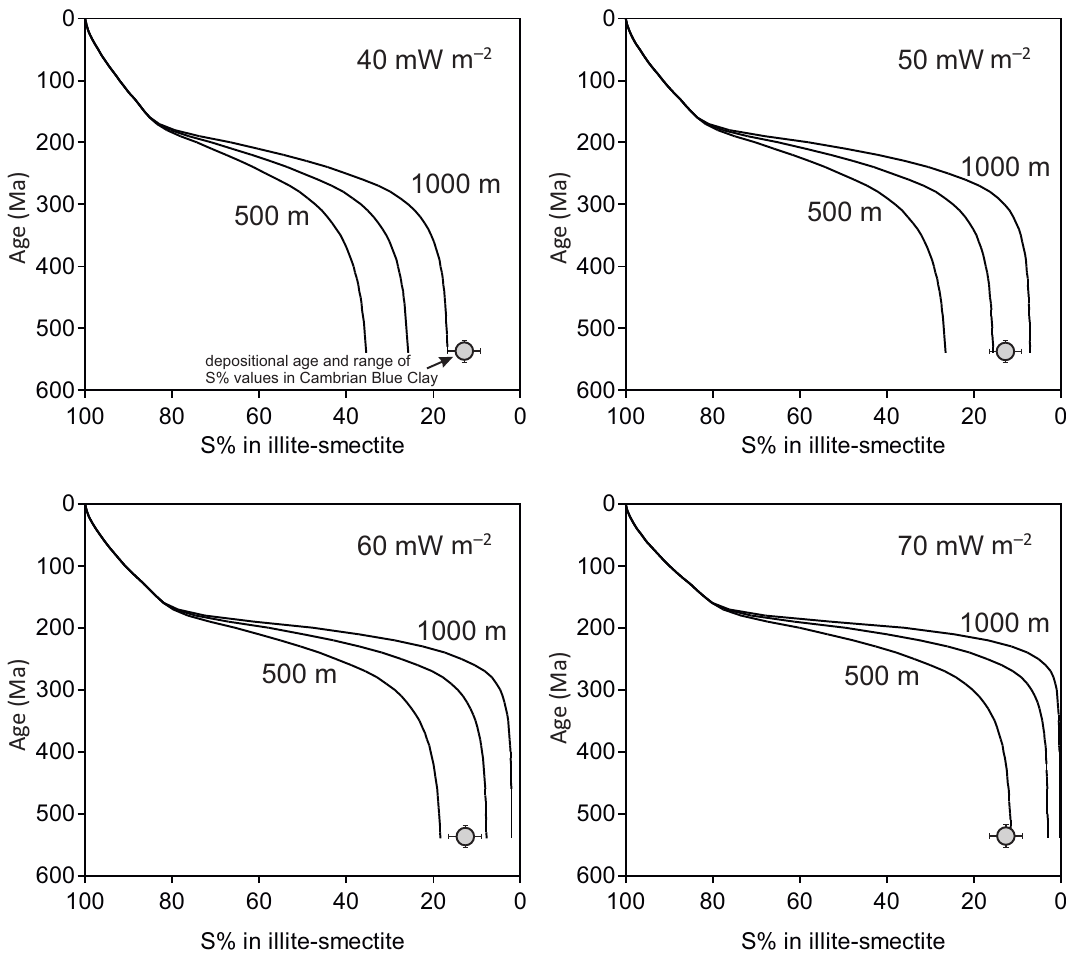
Fig. 6. Estimated increase in smectitic layers (S%) in smectite­to­illite evolution, modelled with a two­step reaction (Velde & Vasseur 1992) assuming different peak burial depths and heat flow